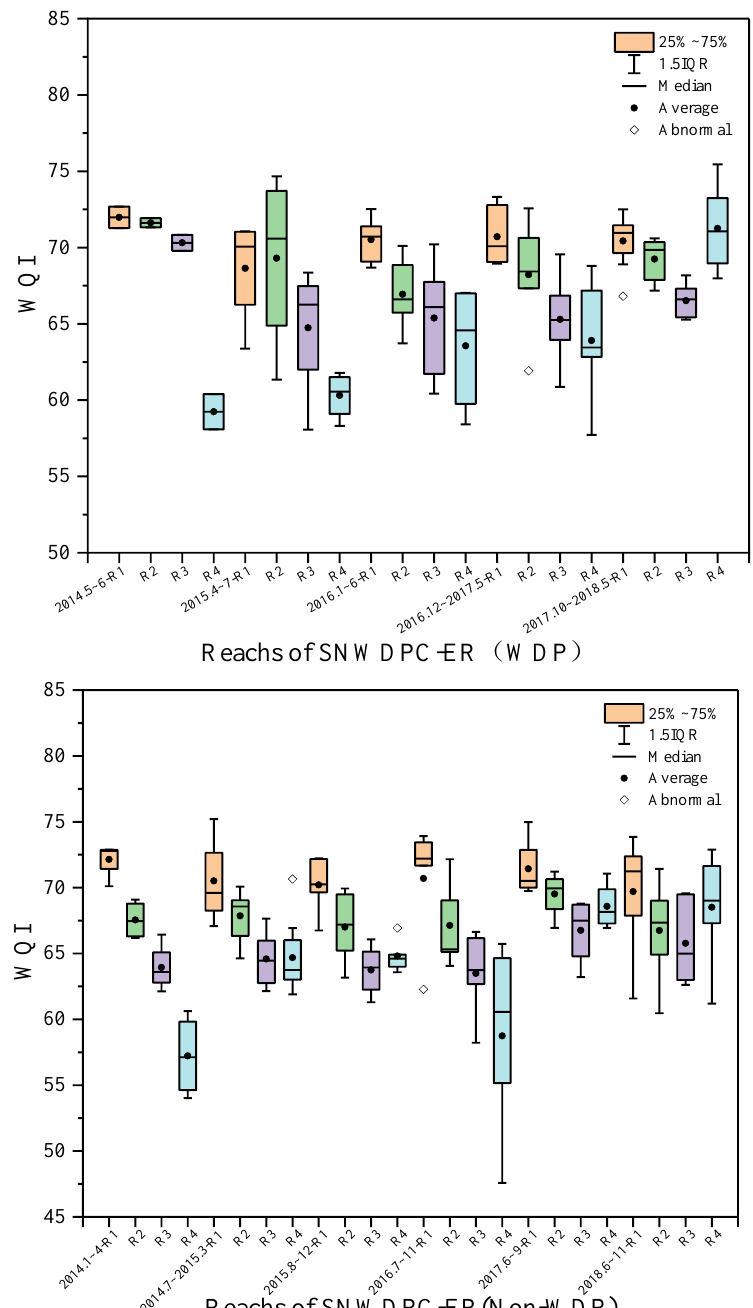
Figure 4. Comparison of water quality evaluations between the water diversion period (WDP) and non–water diversion period (non-WDP) for the SNWDPC-delivery ER’s canal (orange: R1, green: R2, purple: R3, blue: R4).